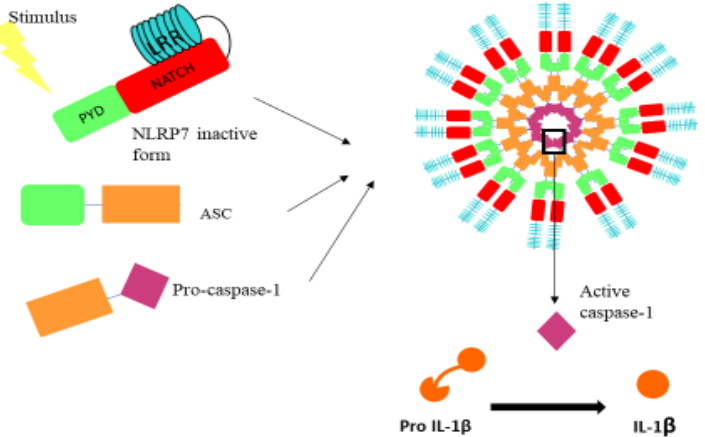
Figure 1. Illustration of the domains that comprise the NLRP7 inflammasome. NLRP7 inflammasome is composed of the NLRP7 receptor, the ASC adaptor protein and procaspase 1. PYD: pyrin domain; NATCH: nucleotide binding domain (allows the ATP-dependent oligomerization of the NLRs); LRR: leucine-rich repeats.